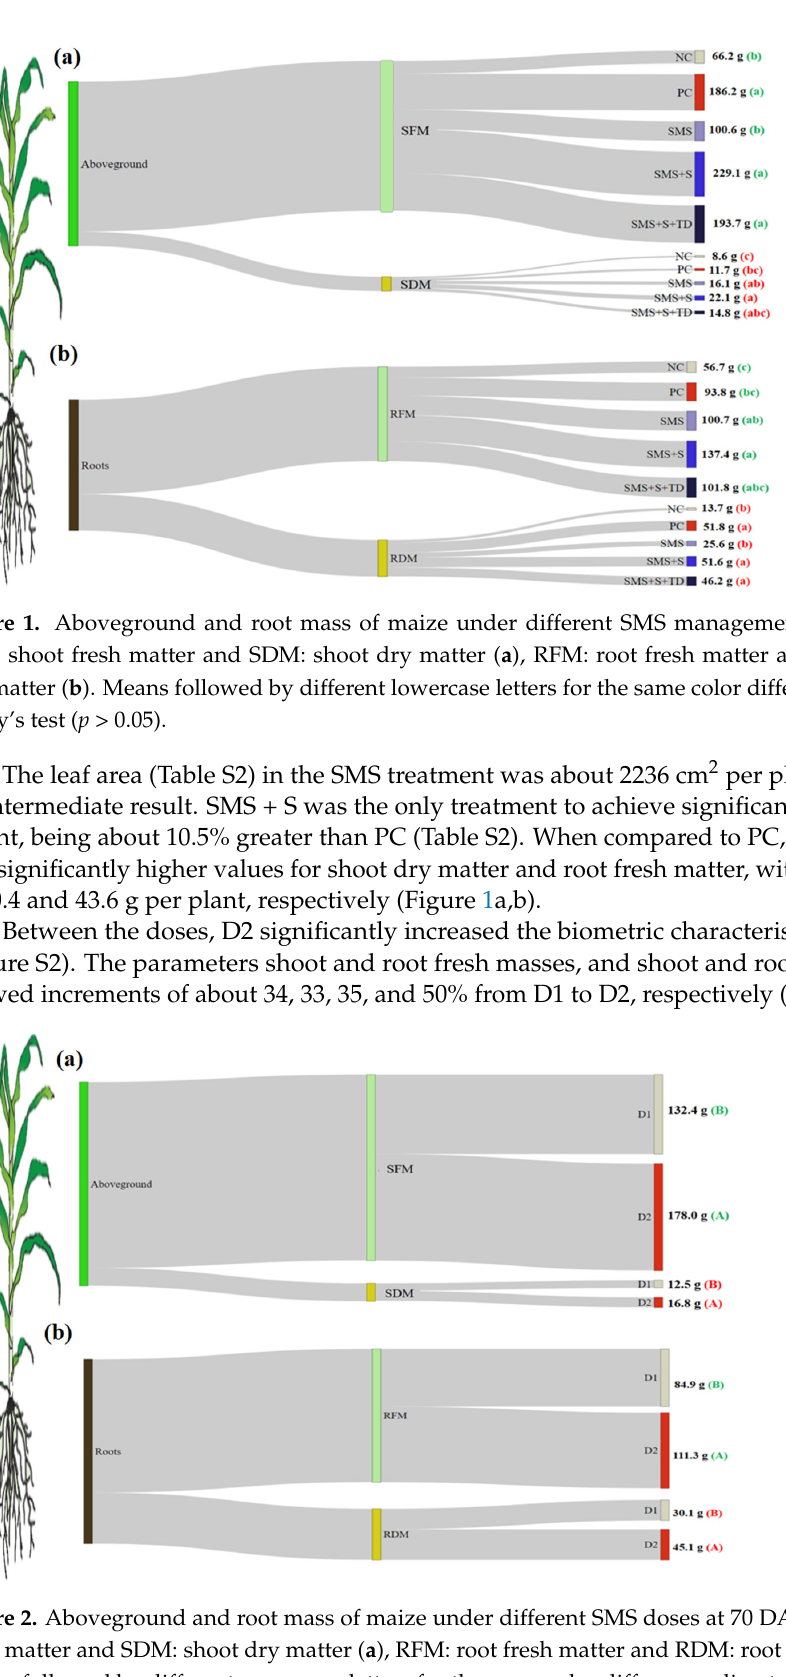
Figure 3. Canonical discriminant analysis (CDA) of 70 DAS maize plants cultivated under different types of SMS management at two different doses. ( a ) Analysis under the SMS Dose 1 condition and ( b ) the condition of double the previous condition—SMS Dose 2. NC: negative control, PC: positive control, SMS: residue application only, SMS + S: SMS application with sowing fertilization, SMS + S + TD: SMS application with sowing and topdressing fertilization.